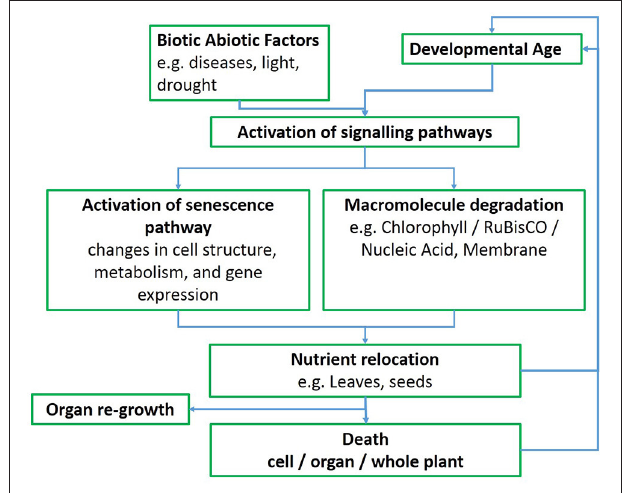
FIGURE 1 | Whole leaf senescence